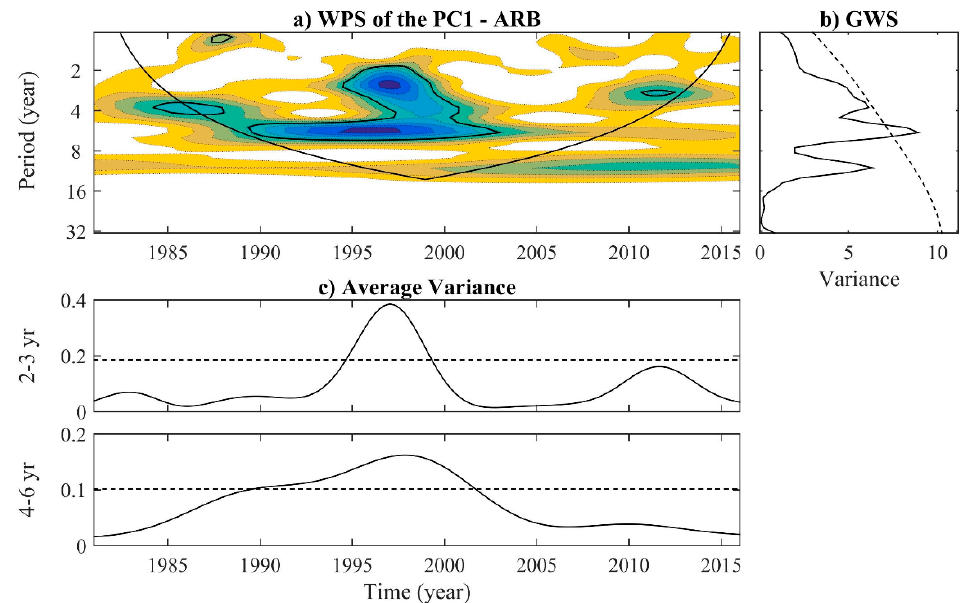
Figure 6. Wavelet analysis of the PC1 of the ARB: ( a ) wavelet power spectra (WPS) of the continuous wavelet transform (the black contours encompass/confine significant variances at the 95% confidence level; the region where the edge effects are significant is above the U-shaped black curve); ( b ) global wavelet spectrum (GWS) in variance units (dashed line denotes significance at the 5% level by assuming a red-noise spectrum); ( c ) scale-averaged wavelet power (SAP) time series for the 2–3- and 4–6-year scales (dashed line indicates the significant value at the 95% confidence level).